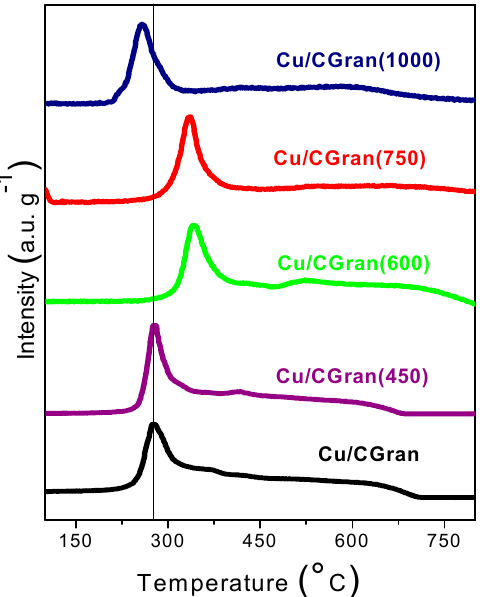
Figure 4. Thermal programmed reduction (TPR) of Cu/CGran and Cu/CGran(x) catalysts.